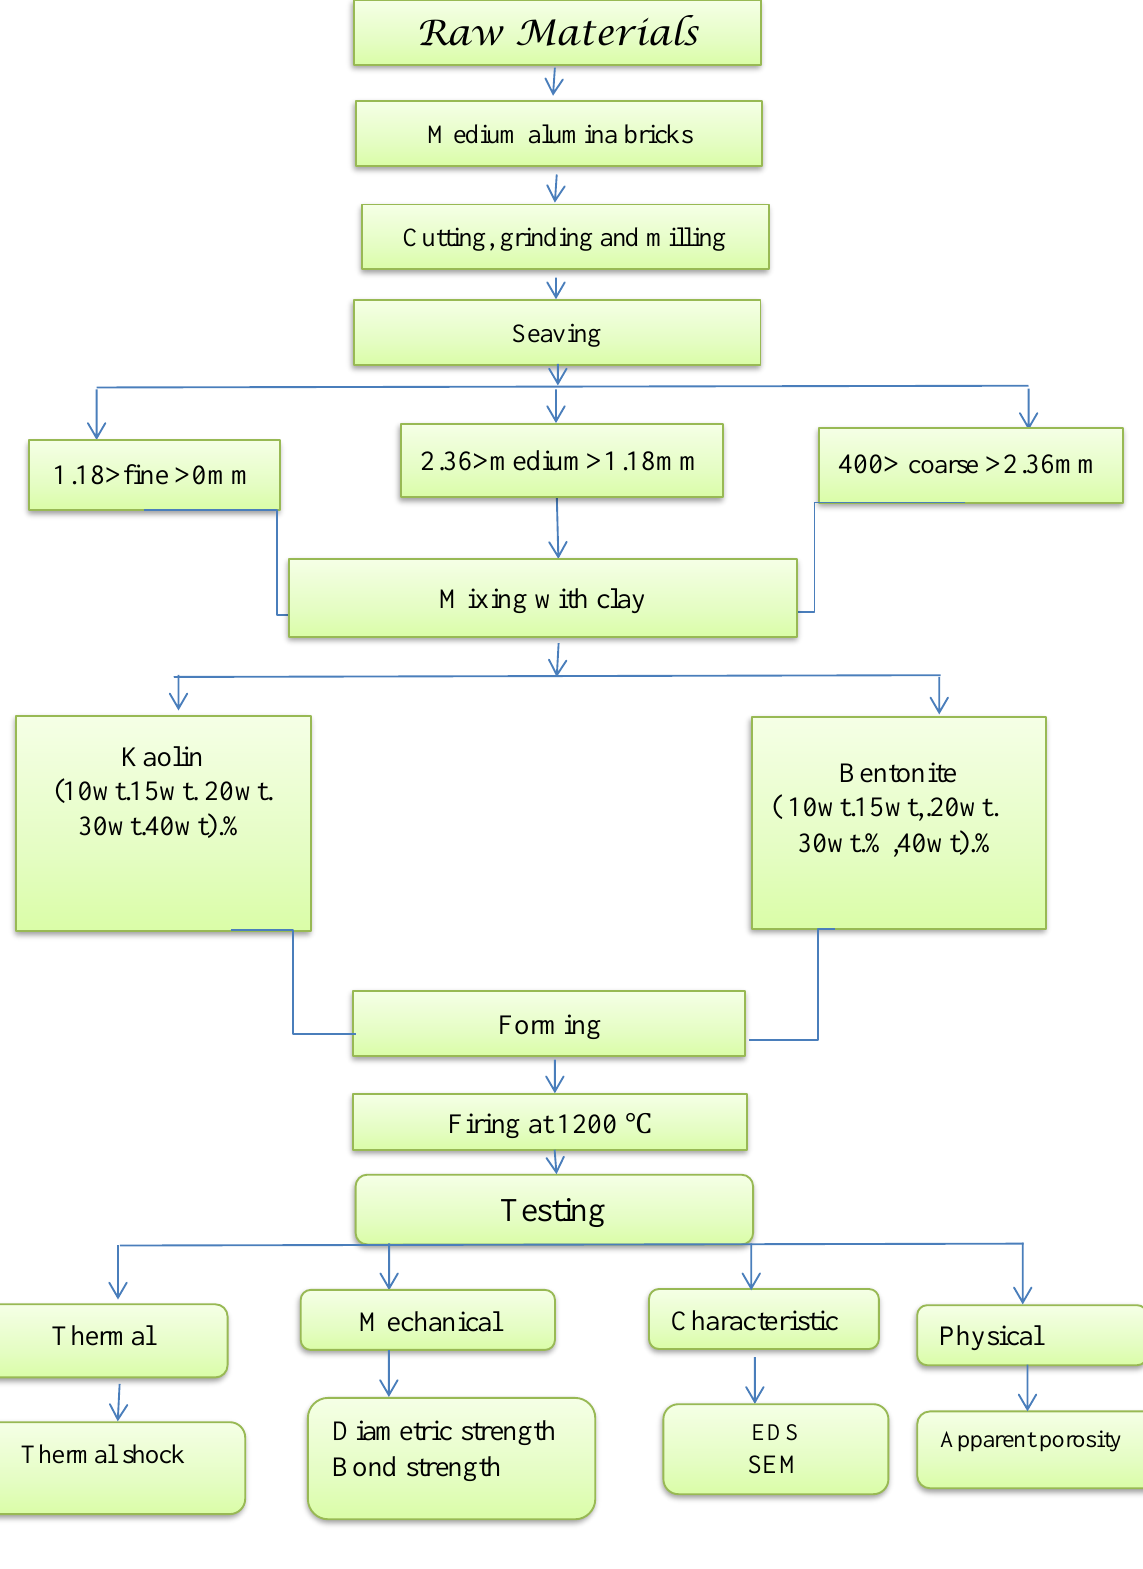
Figure 2 : Chart of the experimental work